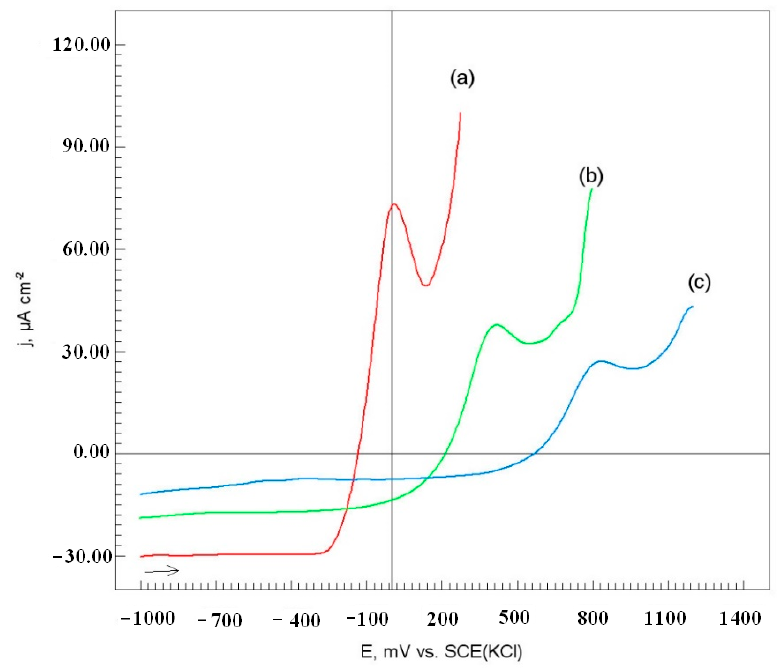
Figure 7. Potentiodynamic polarization curves of Inconel 625 coatings onto the S235JR substrate produced by laser cladding method: (a) Without coating, and with the use of (b) Wire, and (c) Powder. Solutions contained 1.2 M Cl – , pH 1.5, dE/dt 1 mV/s.